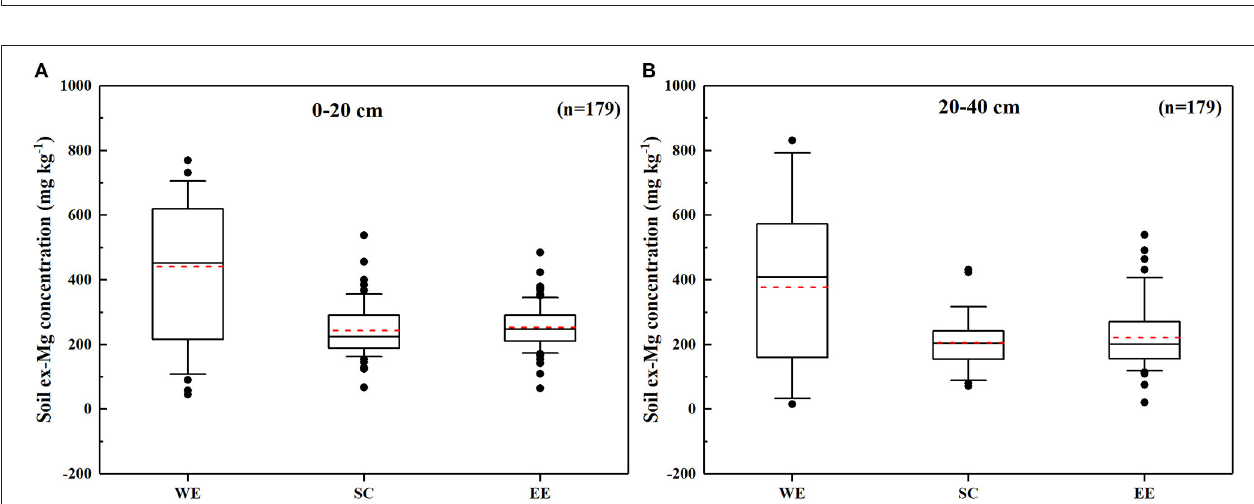
FIGURE 2 | (A,B) Histograms of paddy soil ex-Mg concentrations of in Heilongjiang Province, Northeast China.